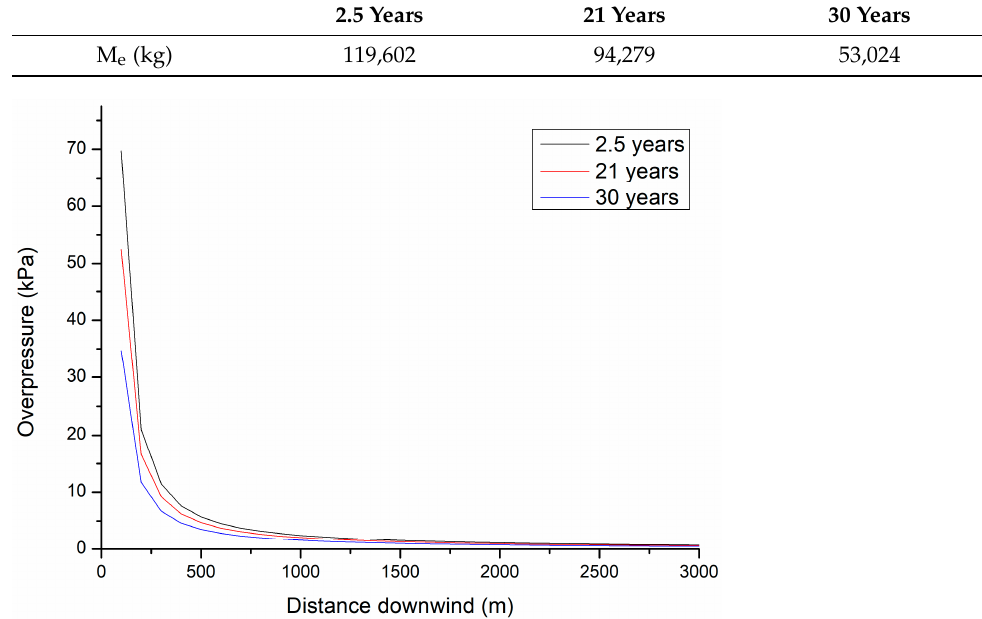
Figure 3. Overpressure (kPa) trend as a function of the distance downwind (m) at 2.5, 21 and 30 years.